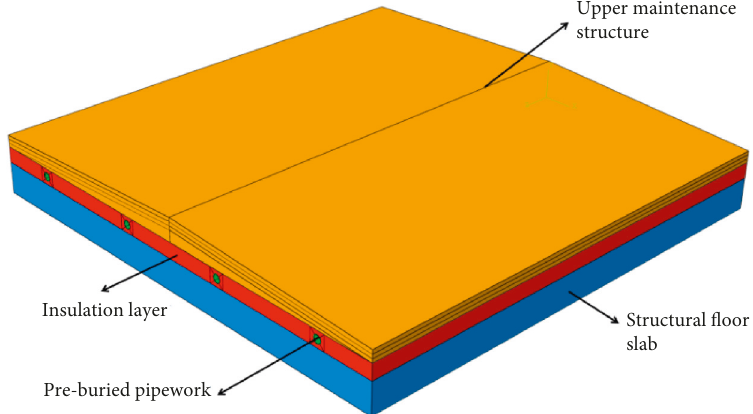
Figure 9: Analysis model. Table 2: Material thermodynamic parameters.